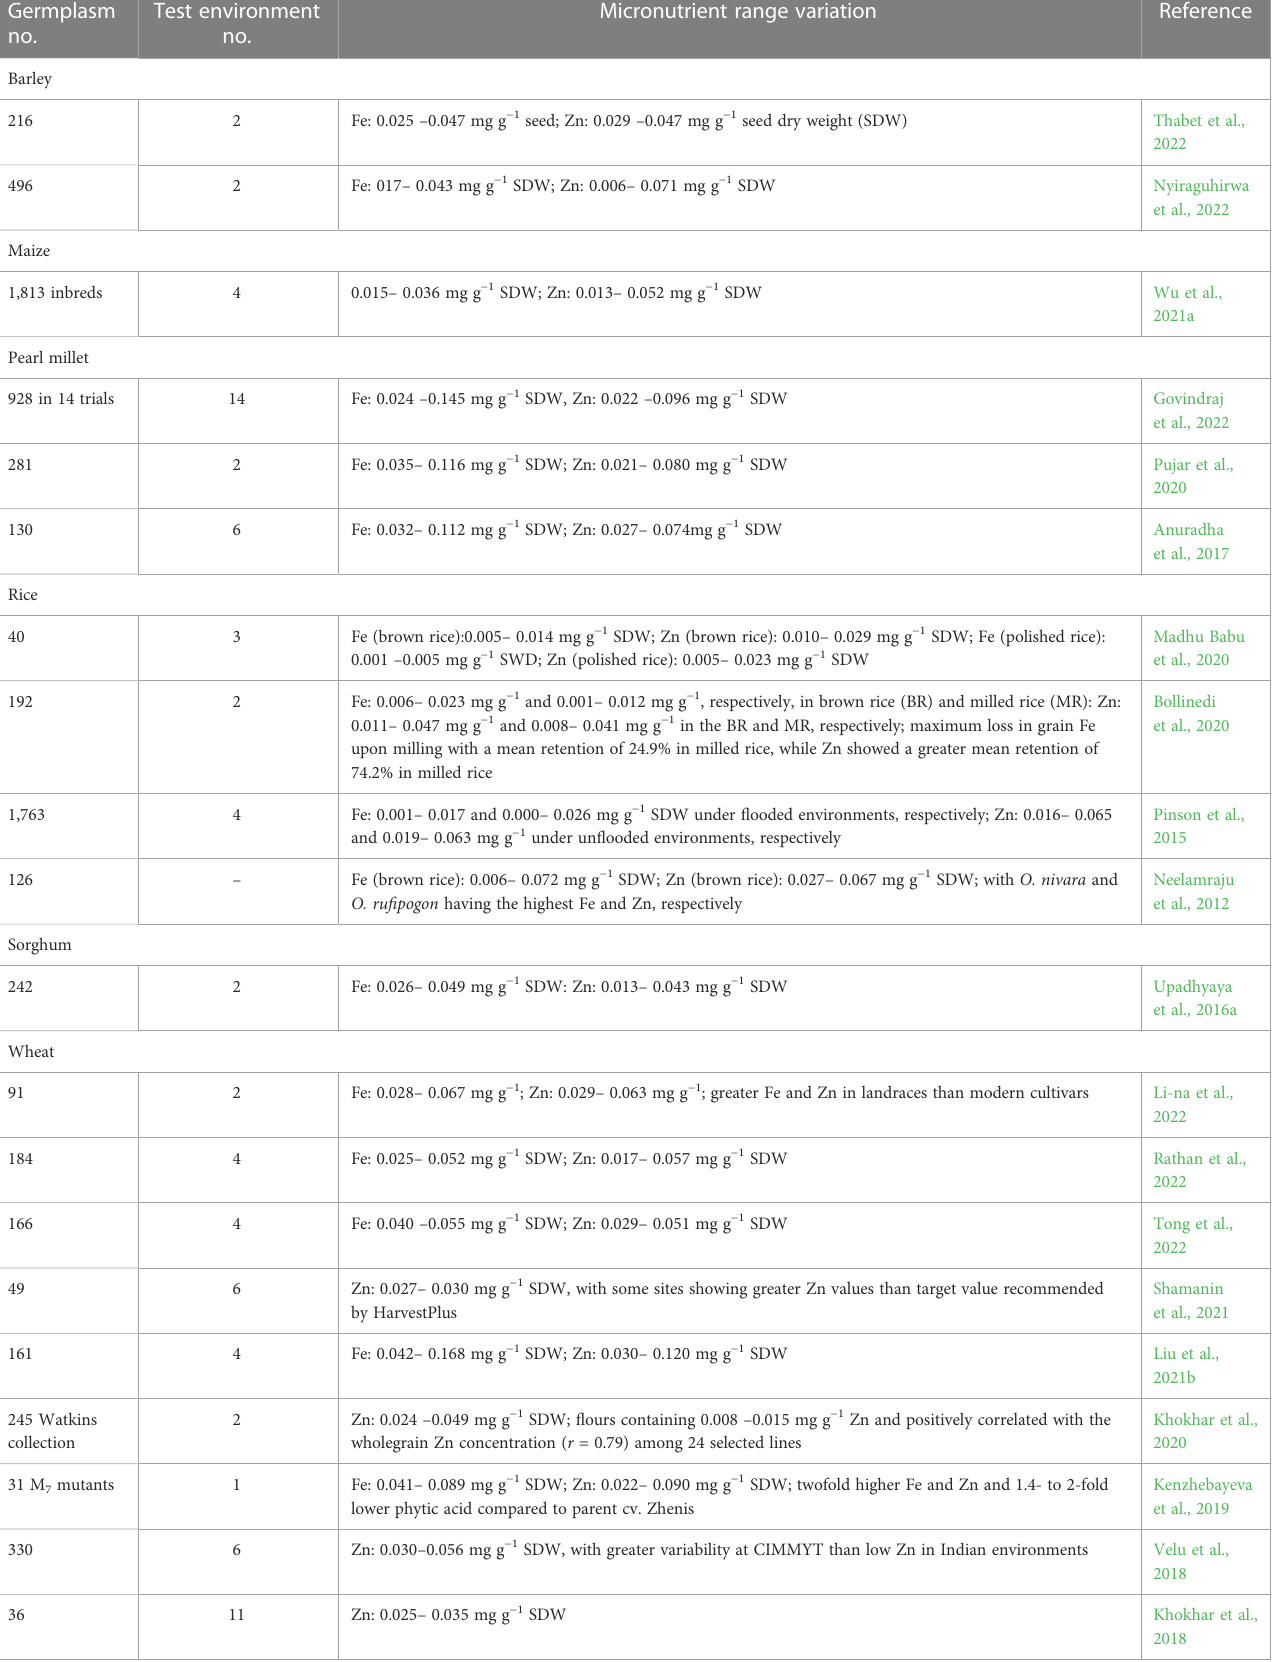
TABLE 1 Genetic variation for seed iron (Fe) and zinc (Zn) contents among cereal crop germplasm. Germplasm